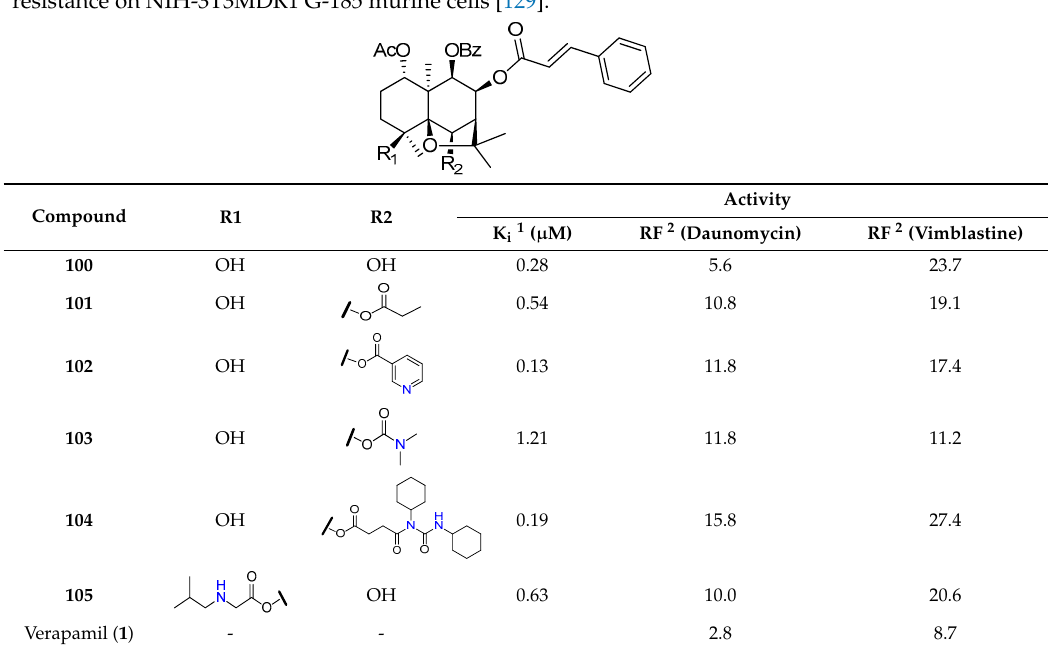
Table 11. Reversal effects of sesquiterpene 100 and its derivatives 101 – 105 of P-gp-mediated daunomycin resistance on NIH-3T3MDR1 G-185 murine cells [129].